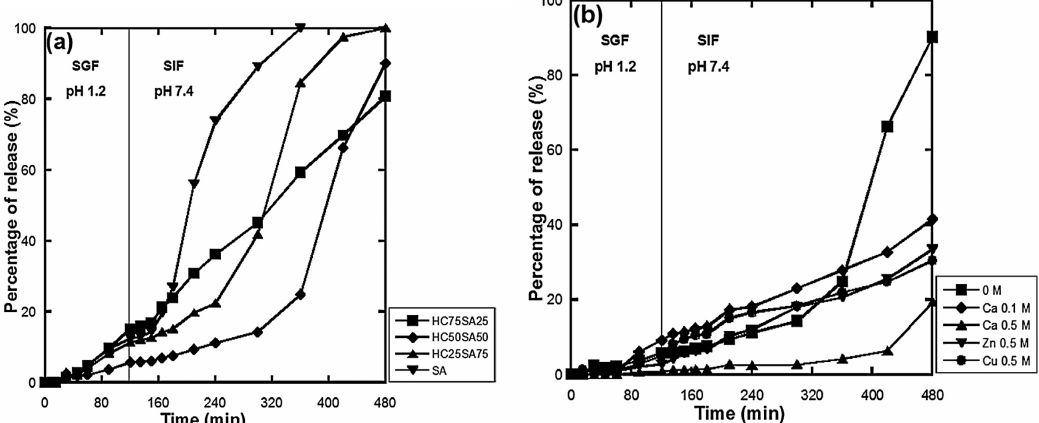
Figure 13. Percentages of paracetamol release from the hydroxyethylacryl chitosan (HC)/sodium alginate (SA) hydrogels after immersing in simulated gastric fluid (SGF) for 2 h followed by simulated intestinal fluid (SIF) for 6 h at 37 ◦ C: ( a ) varying ratios of HC to SA and ( b ) HC50SA50 with varying cross-linker types). (Reprinted with permission from reference [61]. Copyright 2017